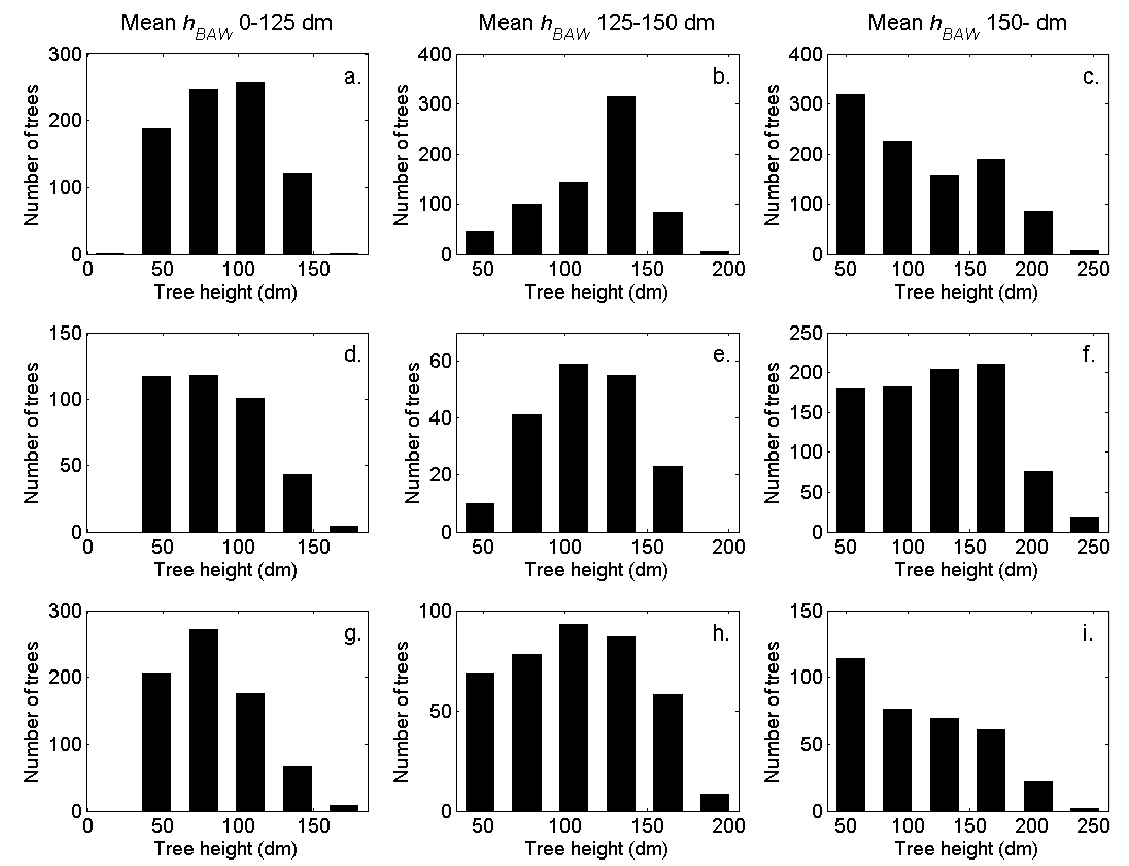
Figure 3. The tree height distributions in the strata defined in Table